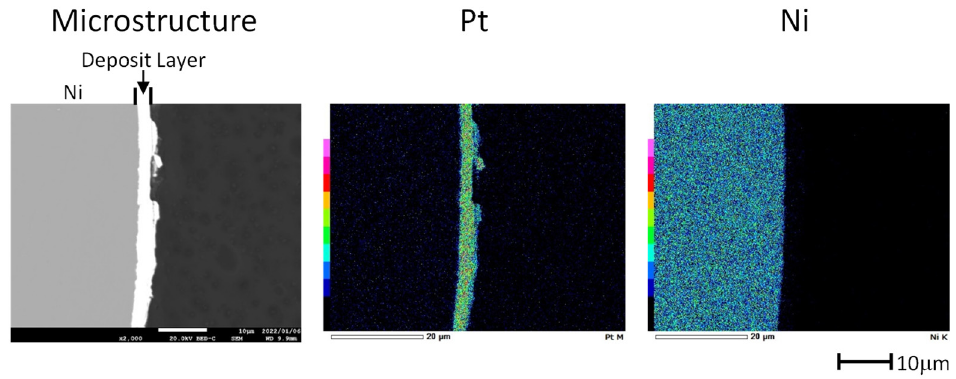
Figure 4. Cross-sectional microstructure and element analysis of Pt-deposited sample on Ni substrate.